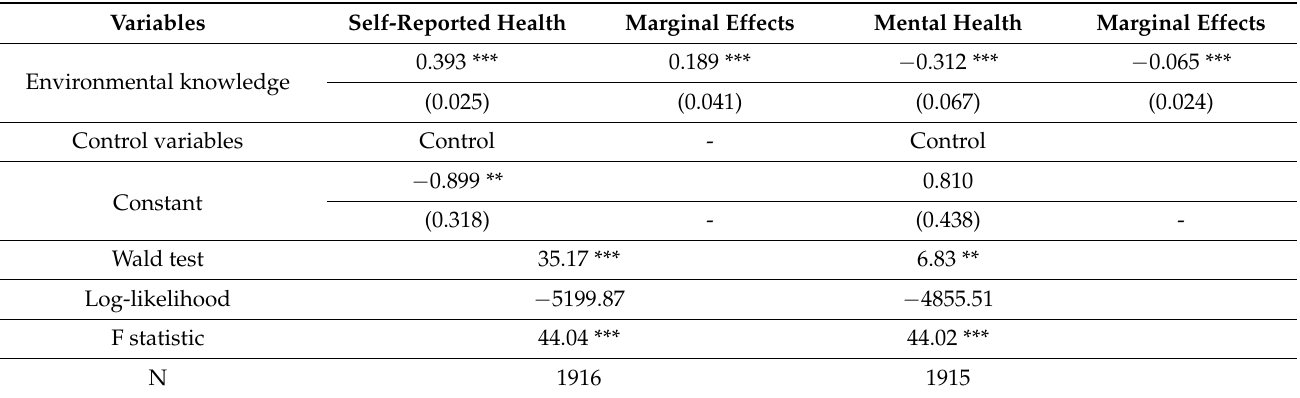
Table 3. The results of the IV-probit